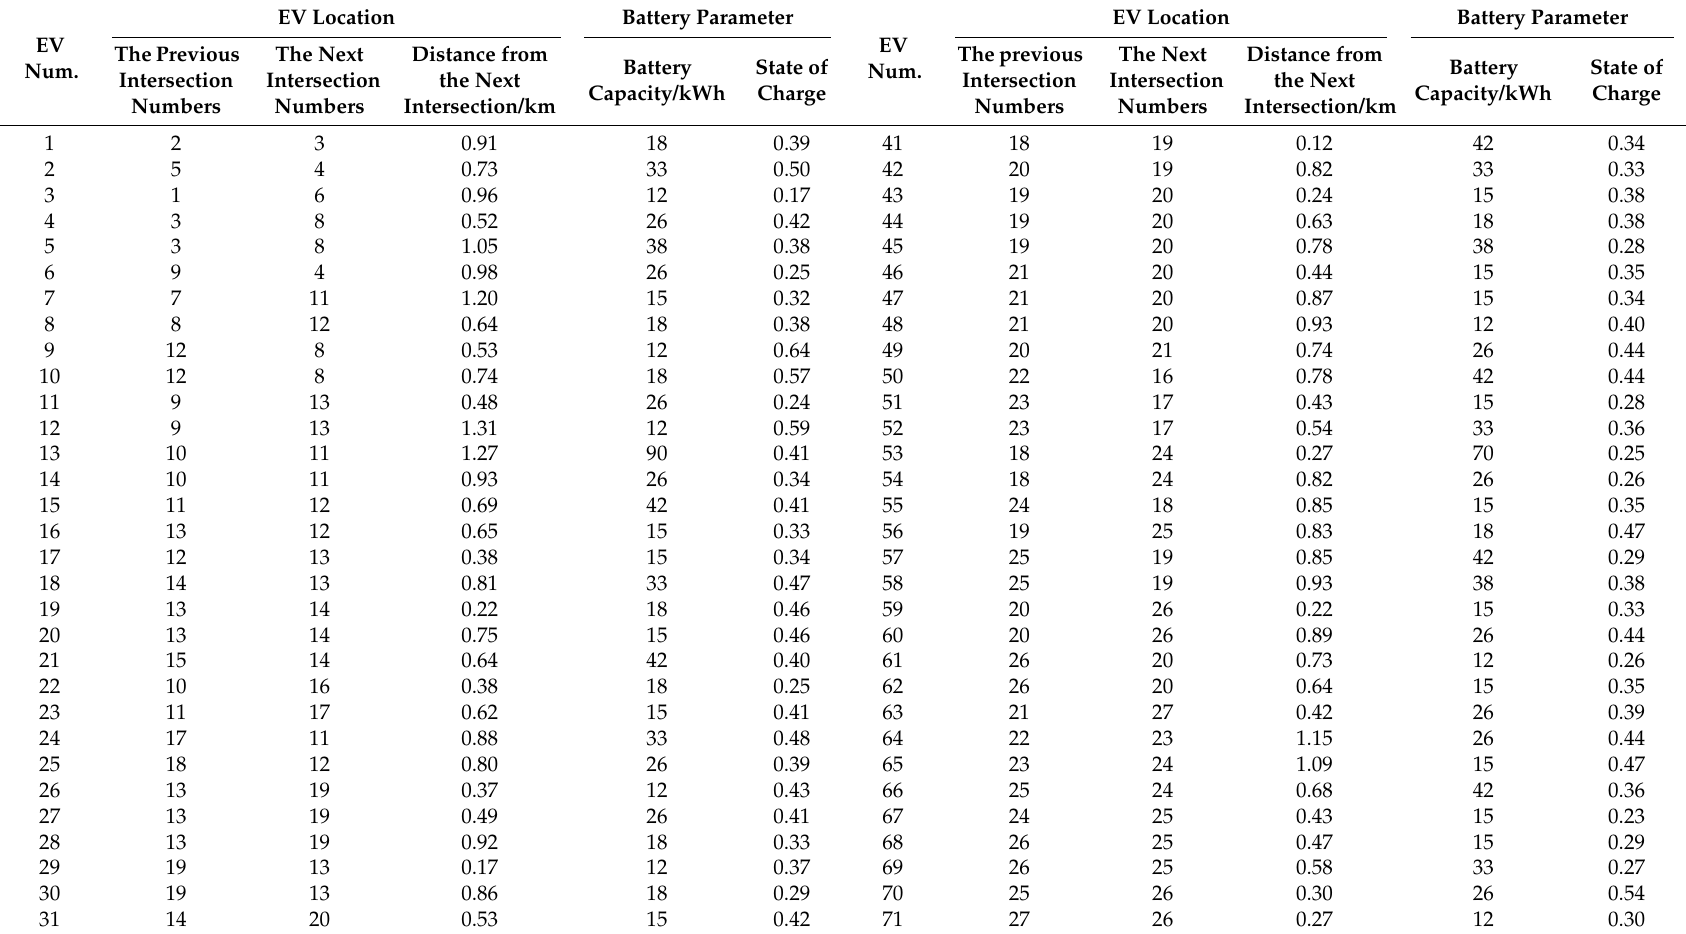
Table A1. Location and battery capacity of fast charging users in the target